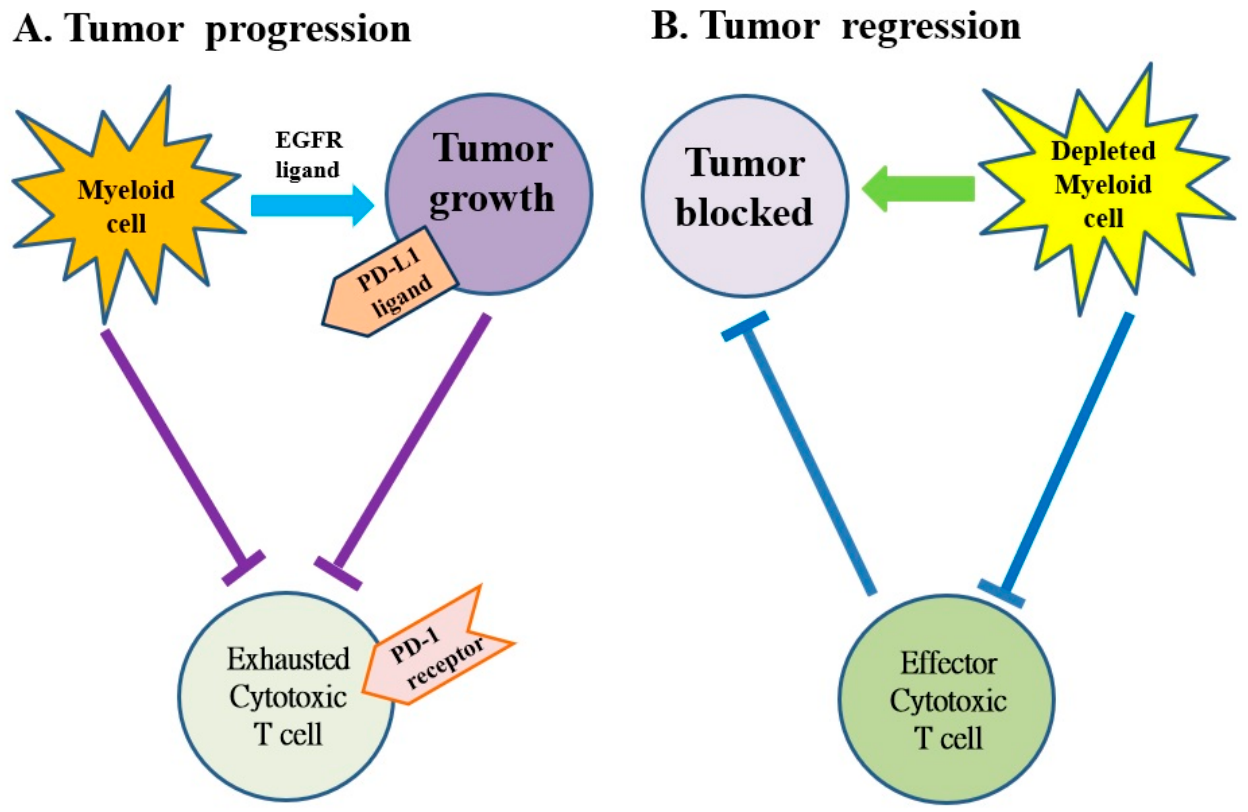
Figure 3. The myeloid cells protect tumor cell viability by blocking the anti-tumor responses of cytotoxic T cells in pancreatic cancer. ( A ) The myeloid cells block anti-tumor immune responses of cytotoxic T cells by activating the programmed cell death-1 (PD-1)/PD-ligand 1 (PD-L1) checkpoint. ( B ) The myeloid cell depletion reverses immune suppression and activates CD8+ T cells to block the growth of tumors. EGFR: epidermal growth factor receptor.